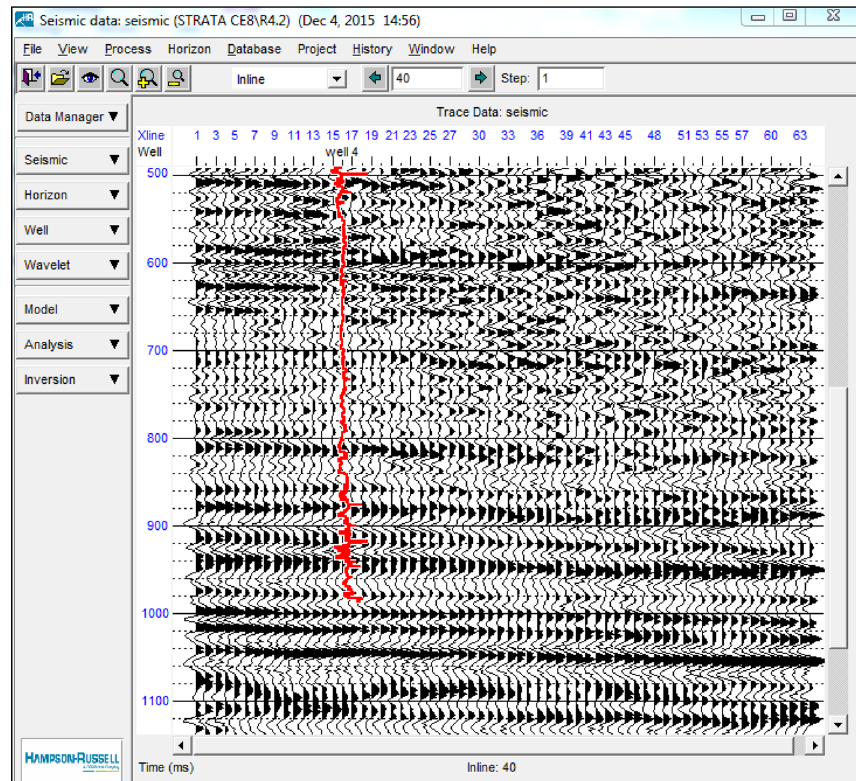
production purposes, of which information from eight was acquired. These include wells 1, 2, 4, 5 6, 10, and 12, which